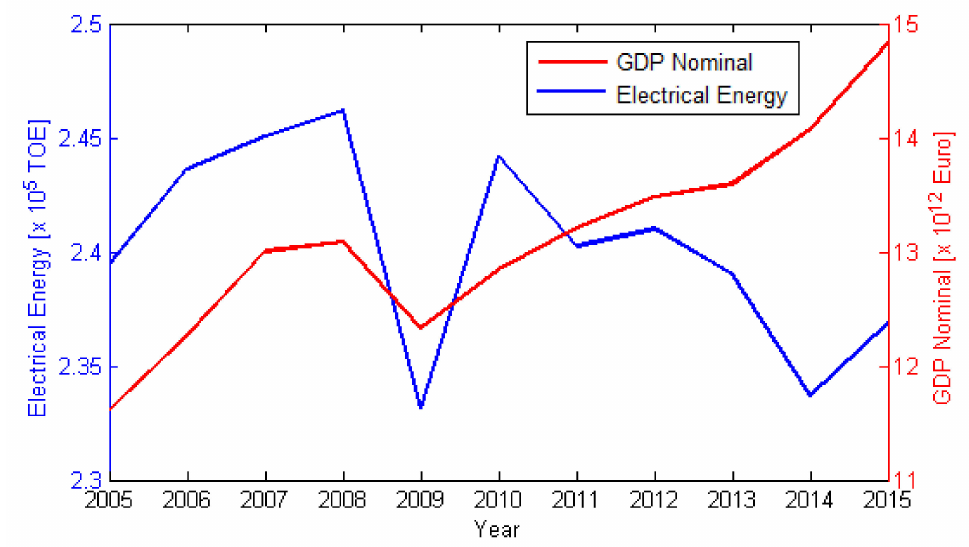
Figure 11. Comparison between Nominal GDP and Electrical Energy over the EU during 2005–2015, where TOE represents a tonne of oil equivalent (source: